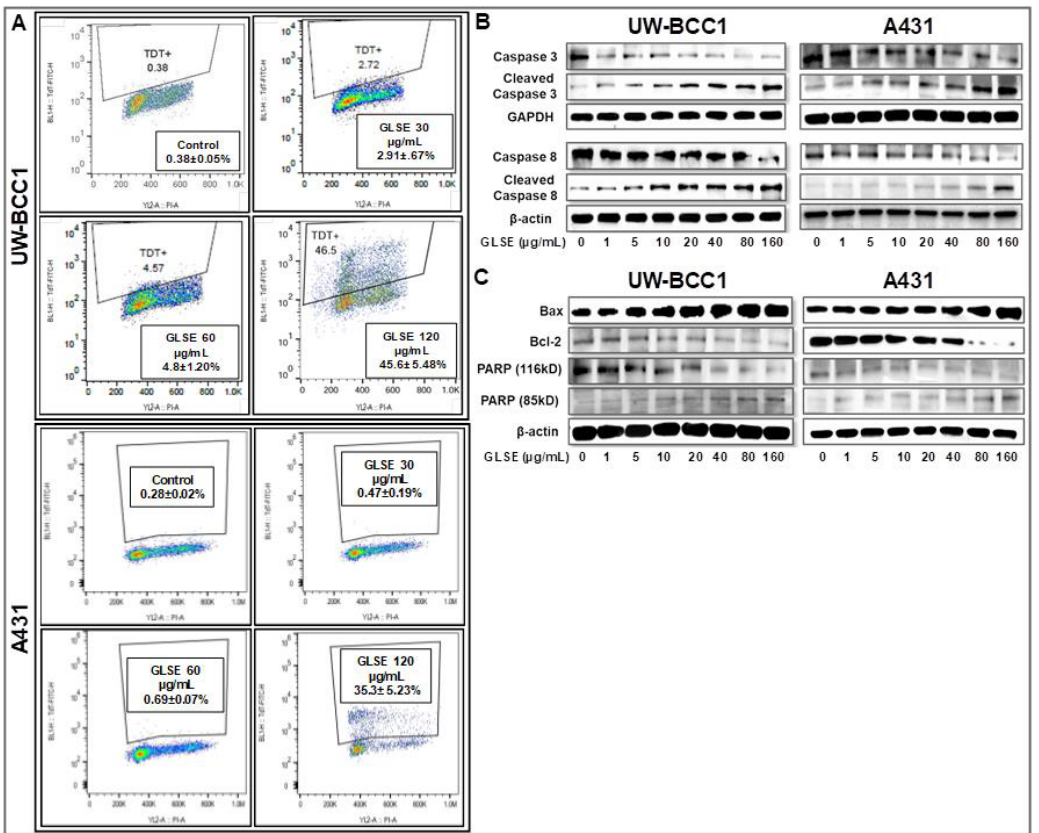
Figure 3. GLSE induces apoptosis of UW-BCC1 and A431 cells through activation of caspases 3/8, and PARP, and suppression of Bcl-2. ( A ) UW-BCC1 and A431 cells treated with or without GLSE (0–120 µ g/mL: 24 h) were labeled with the Apo-Direct kit and analyzed by flow cytometry. Percentage of apoptotic cells observed (mean ± SD) with each dose of GLSE are shown in the box inserts in each panel. All experiments were performed in triplicate. ( B , C ) Whole cell lysates of UW-BCC1 (left panels) and A431 cells (right panels) treated with/without GLSE (0–160 µ g/mL, 24 h) were subjected to SDS-polyacrylamide gel electrophoresis and blots were probed with antisera to proteins involved in apoptosis pathways, showing ( B ) expression levels of caspase-3 and caspase-8 in both the intact and cleaved forms; and ( C ) expression levels of Bax, Bcl-2 and PARP, the latter in both the 116 kDa and 85 kDa forms. Equal protein loading was confirmed by re-probing with β -Actin or GAPDH. The immunoblots shown are representative of three independent experiments with similar results. Data represent the means of three independent experiments each conducted in triplicates ± SD vs. control (DMSO-treated cells), and bar graphs for ( B ) and ( C ) representing the means ± SD are presented in Figure S6.